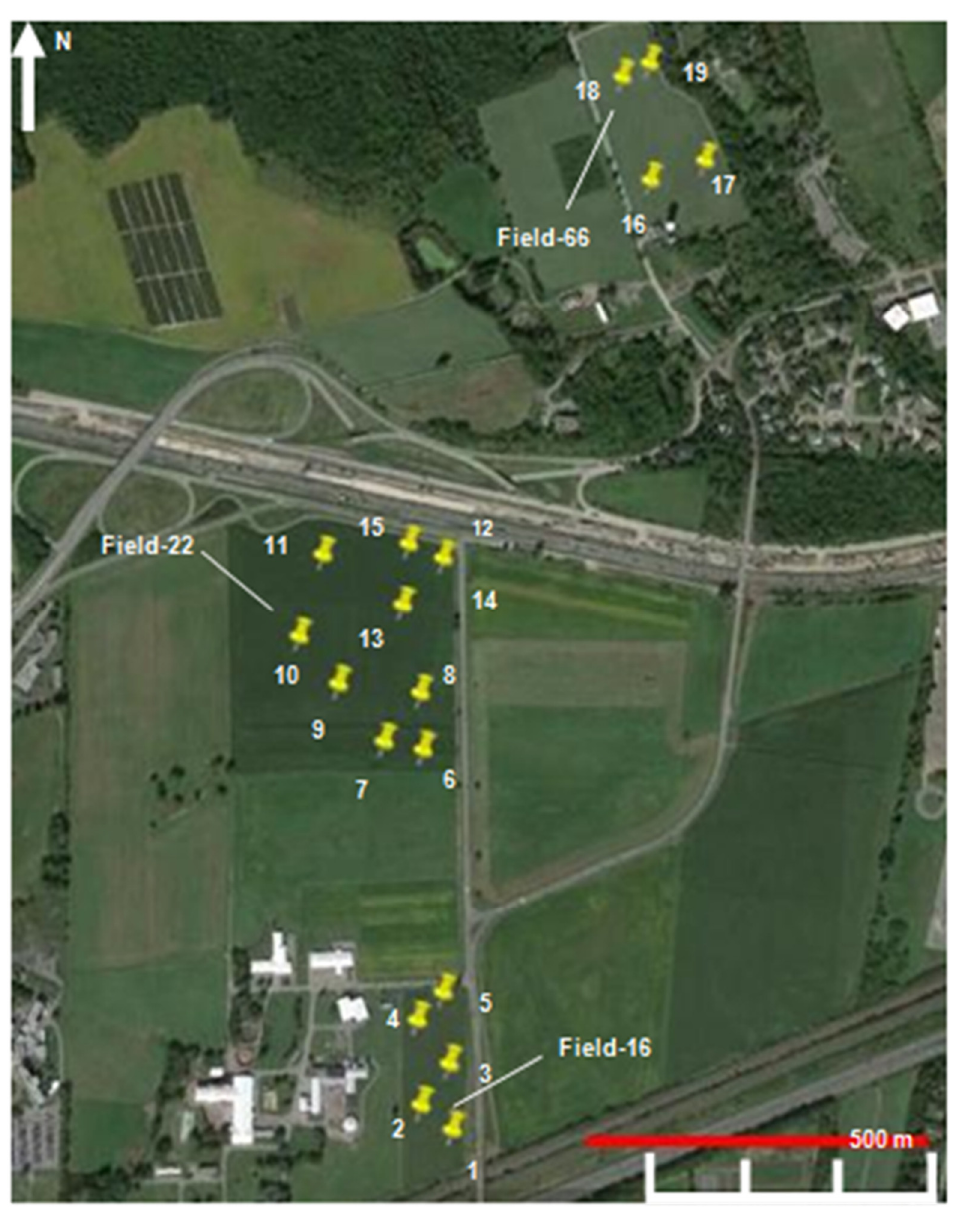
Figure 2. Google earth view of McGill University Macdonald research farm site, illustrating sam- pling points.